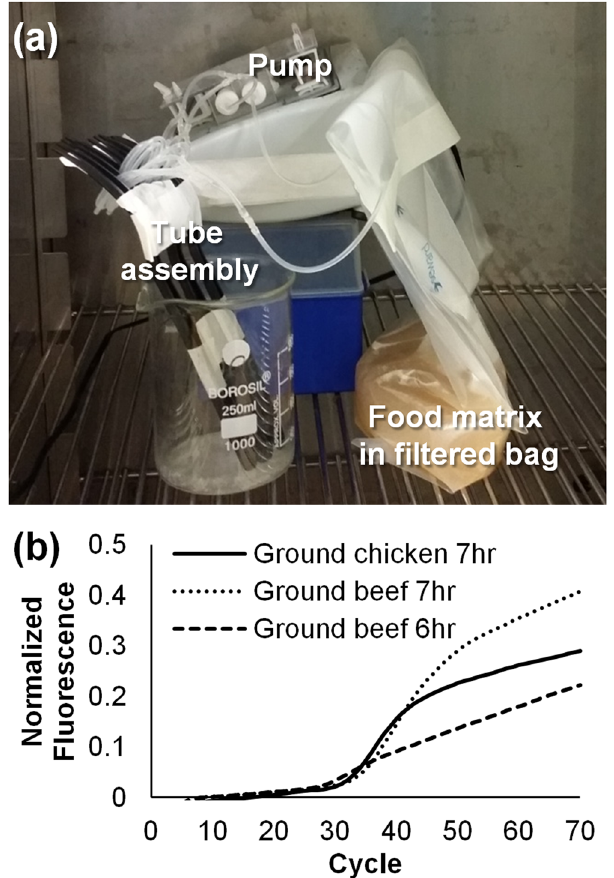
Figure 7. Tube capturing in a real food matrices; ( a ) Experiment set-up for capturing in ground chicken. ( b ) RT PCR detection of S . typhimurium in ground chicken at initial concentration ~25 CFU of S . typhimurium in 250 mL sample containing 25 g ground chicken in BPW and ground beef in Selective Romer Labs’ primary media with phage supplement at the same concentration, capturing completed within 6 or 7 hours (DNA extracted by magnetic bead